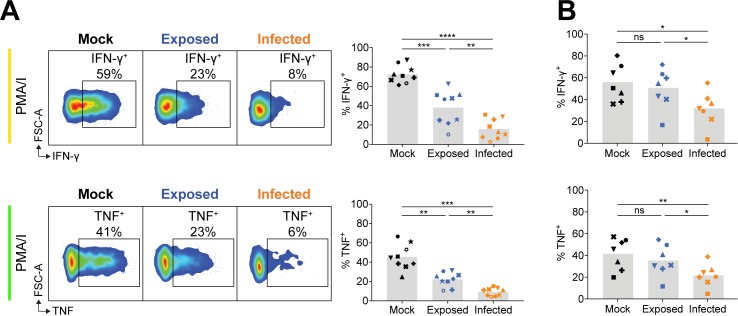
VZV infected NK cells produce less IFN-γ and TNF upon PMA/I stimulation.PBMCs were mock cultured, exposed to VZV, or VZV infected for 2 days (A) or 1 day (B) and stimulated with PMA/I for flow cytometry analysis of IFN-γ (top panels) or TNF (bottom panels) expression by NK cells (viable CD3–CD56+ cells). Symbols represent individual donors, and grey columns indicate mean. *P < 0.05, **P < 0.01, ***P < 0.001, ****P < 0.0001, ns = not significant (Repeated measures one-way ANOVA with Tukey correction (A) or Friedman test with Dunn’s correction (B)). Data are from nine donors (A) or seven donors (B).